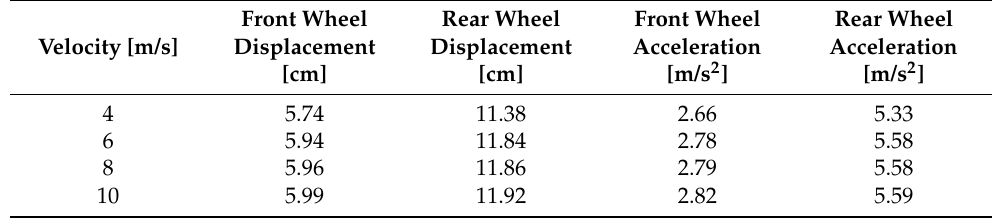
Table 3. Maximum net displacement and acceleration of front and rear wheels at different speeds.